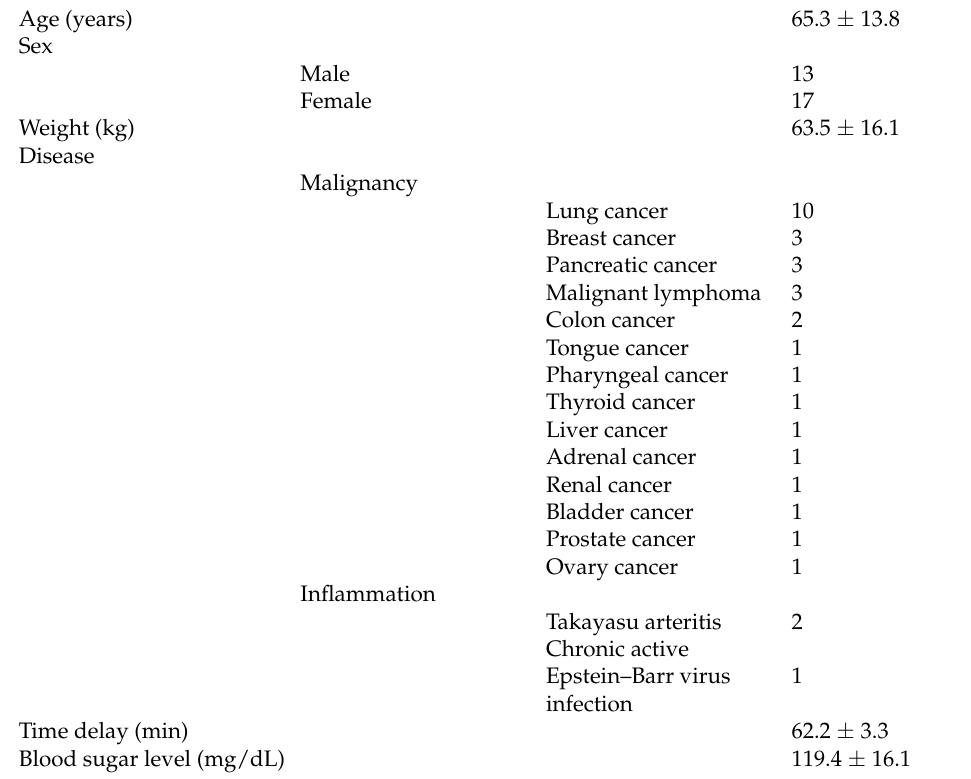
Table 1. Patient demographic and clinical data ( n = 30).